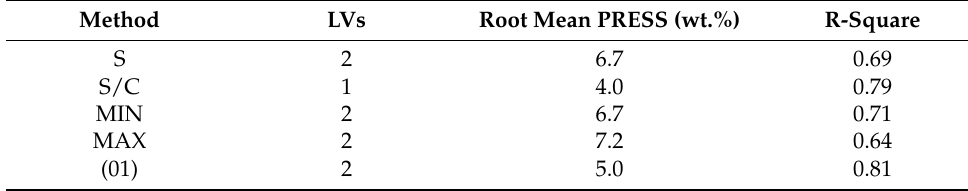
Table 5. Characteristic values derived from the PLS-R